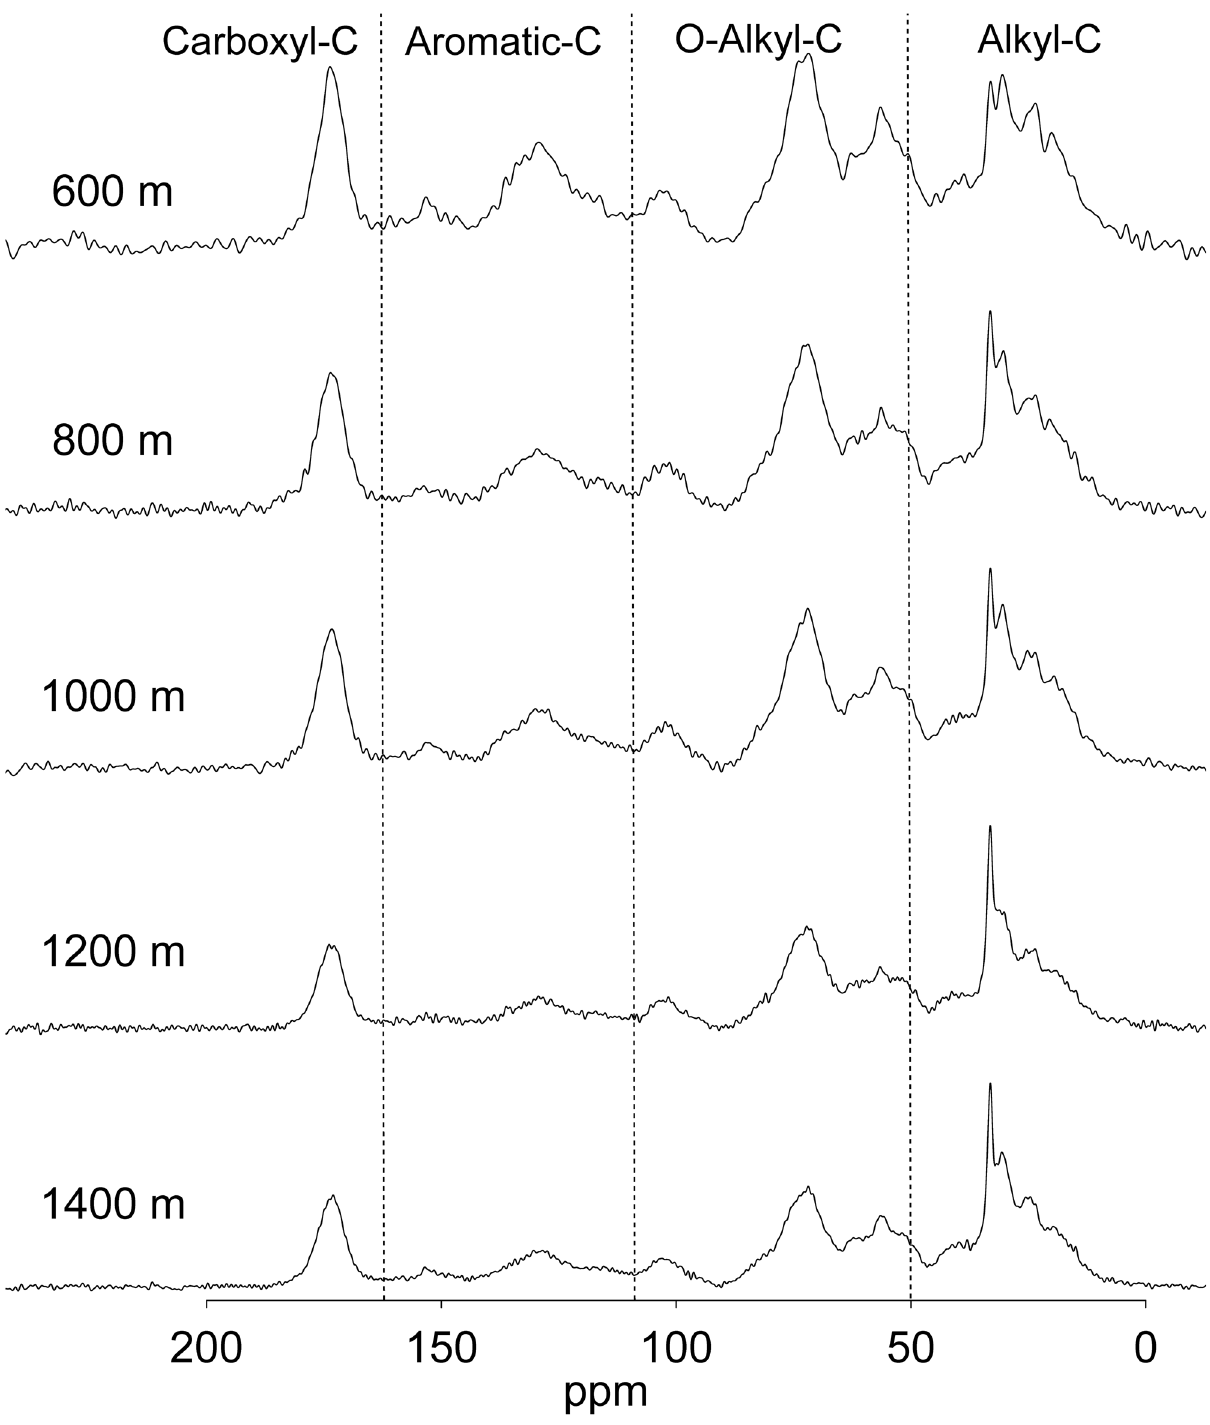
Fig 2. The 13 C NMR spectra of soil humic acids in five bamboo plantations at 600, 800, 1000, 1200 and 1400 m asl. The chemical shift regions were 0 – 50 ppm (alkyl-C), 50 – 110 ppm (O-alkyl-C), 110 – 165 ppm (aromatic-C), and 165 – 190 ppm (carboxyl-C).